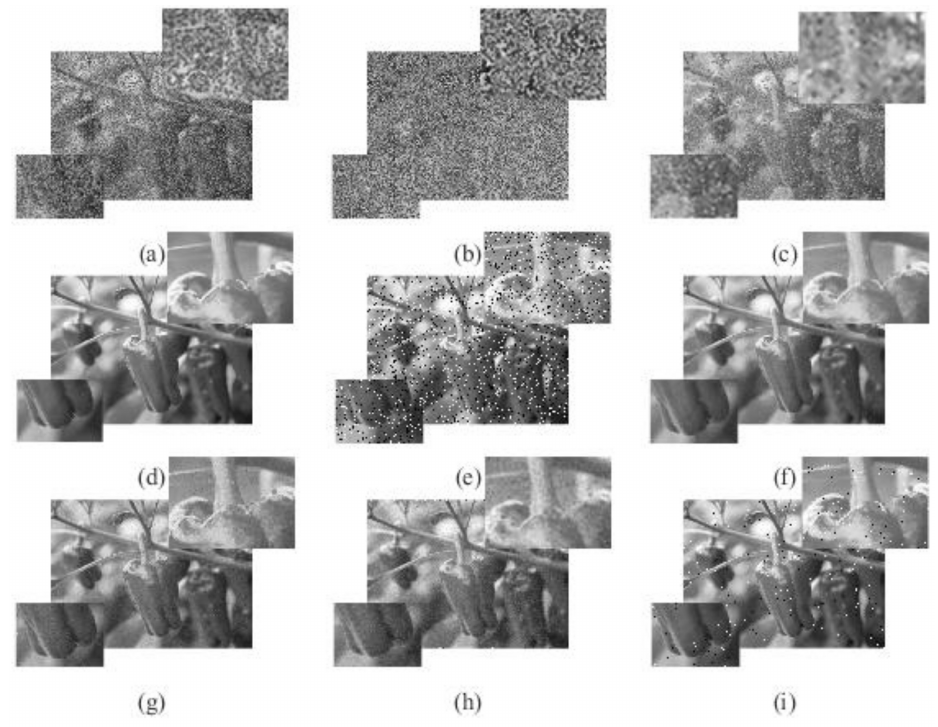
Figure 8. Pepper image: ( a – c ) the noise-suppression BIMF 1 to 2 and the residue, ( d ) The proposed BEMD-GWO-PCNN reconstruction image, ( e ) median filter, ( f ) PSO-PCNN method, ( g ) GACA-PCNN, ( h ) COR-PCNN, ( i )